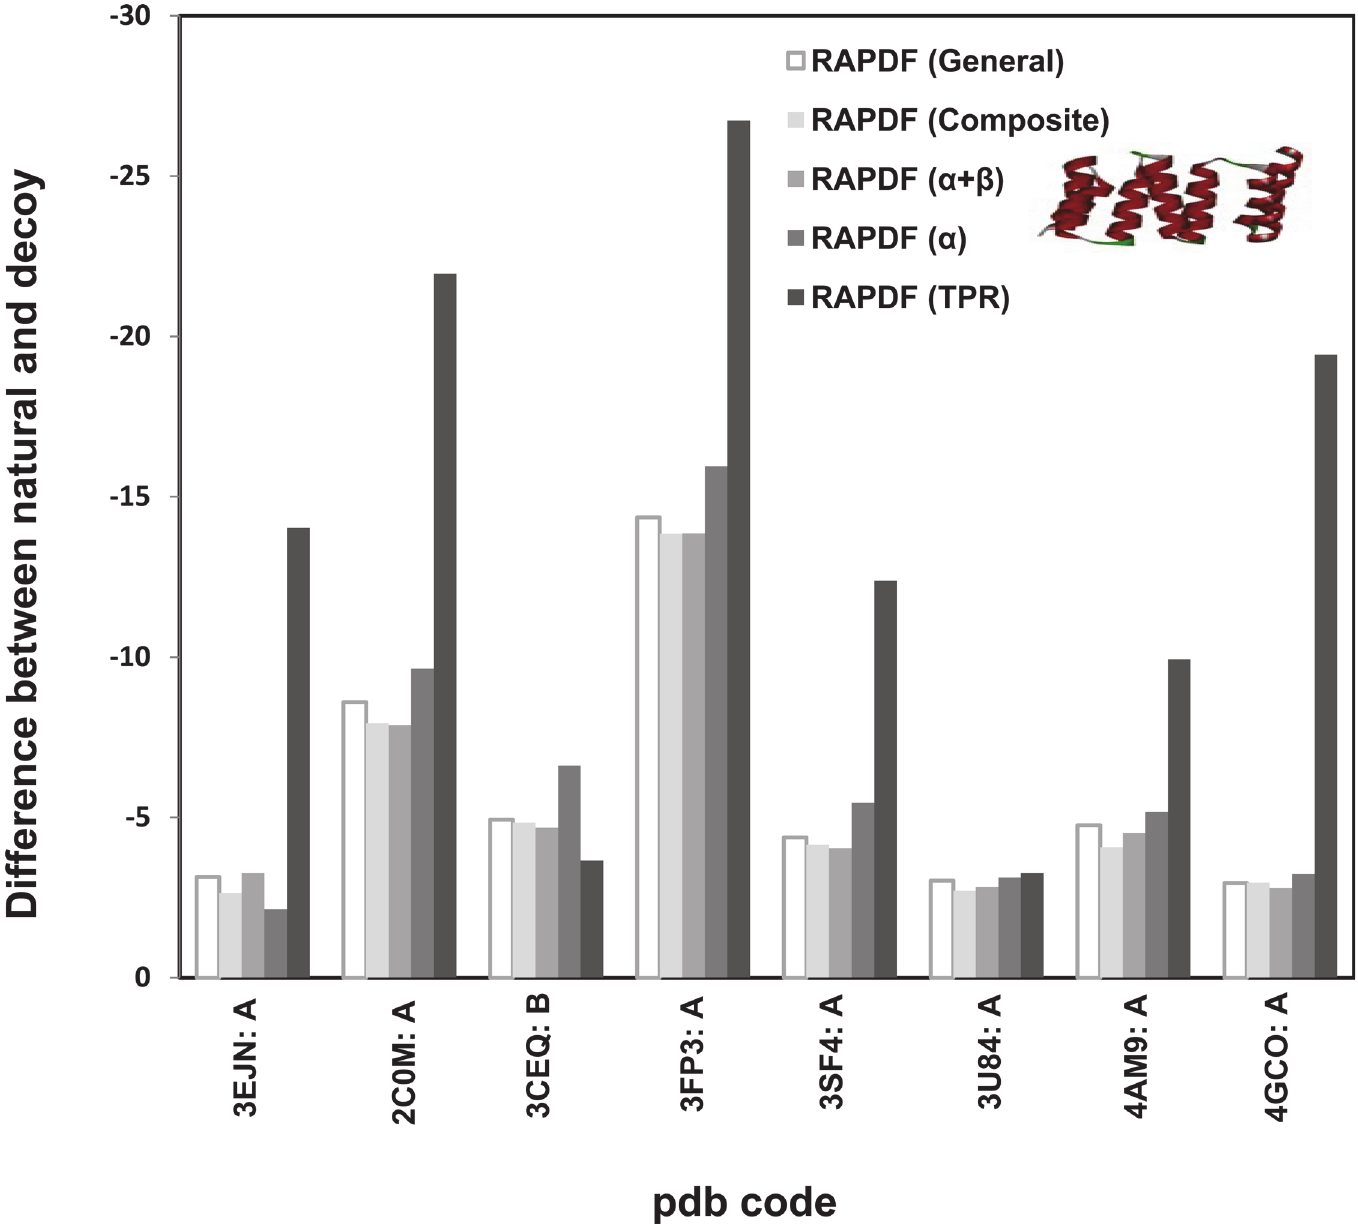
Fig 7. Distance-dependant statistical potential based on TPR protein library (73 proteins) . Homology models were used as decoys. RAPDF (TPR) represents the statistical RAPDF scores calculated using the TPR